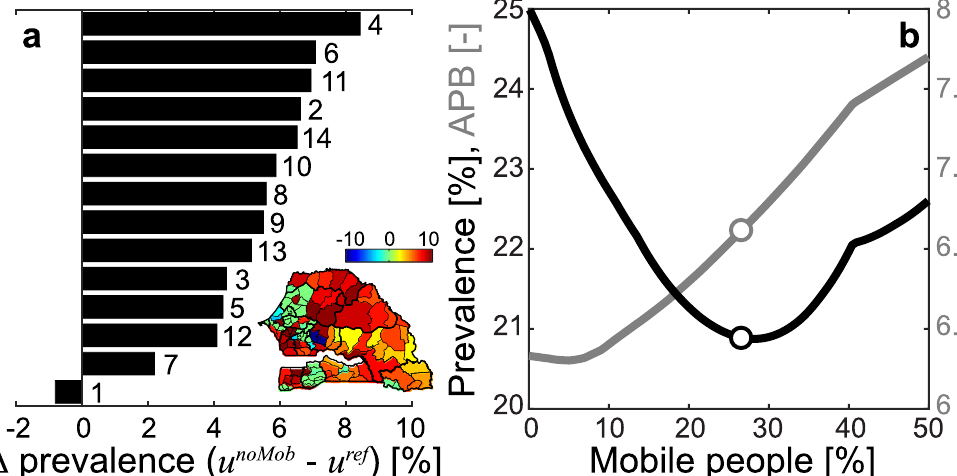
Figure 3. Effects of human mobility on schistosomiasis prevalence. ( a ) Differences [%] in regional disease prevalence (labels as in Fig. 1b) as predicted by the reference model (M4, mobility matrix estimated from CDRs) or by a model with the same parameter values but no mobility (mobility matrix set to be the identity matrix); positive values indicate higher prevalence in the model without mobility (absolute differences sorted in decreasing order). Inset: arrondissement-scale differences in infection prevalence: positive values indicate again higher prevalence in the model without mobility. ( b ) Projected country-scale disease prevalence (black, left axis) and APB (gray, right axis) as a function of the fraction of mobile people (those who leave their home arrondissement at least once a year). The dots indicate infection prevalence and APB corresponding to the mobility level inferred from CDR analysis (26%). Different levels of human mobility have been obtained by artificially manipulating the mobility matrix estimated from data (SI). Parameters as in Fig. 2. The map in the inset of panel (a) has been created with QGIS 2.4 (QGIS Development Team, QGIS: A free and open source geographic information system, http://www.qgis.org/; last date of access: 03/02/2017) and MATLAB